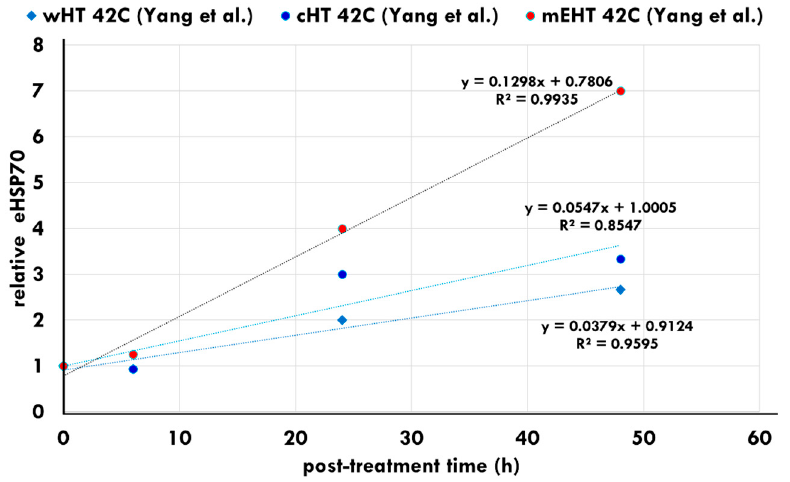
Figure 8. eHSP concentrations following water heating (wHT), capacitive heating (cHT), and heating using mEHT. The increase in eHSPs is significantly higher following mEHT heating compared to the other heating techniques [75]. The inoculation of tumors into two different regions in vivo, e.g., the left and right femoral region [108], or the femoral and thoracic region [109], is a popular method for evaluating tumor responses to treatment as each tumor has its control in the same animal. When both mice’s femoral regions were inoculated with xenografted human colorectal cell line (HT29) tumors [108], the right tumor of each mouse had a treatment with 30 min of mEHT, and their left tumor remained untreated. After treatment, resected samples showed an increase in HSP60 and HSP70 concentration in the treated tumors, peaking at eight hours post-treatment [102] (Figure 9a,b).